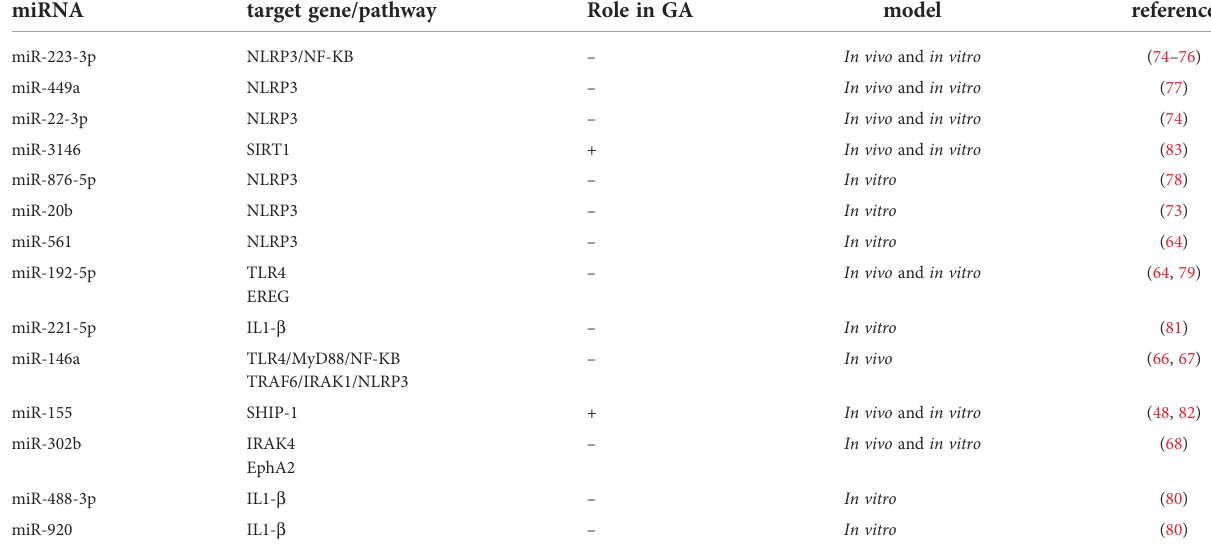
TABLE 2 The miRNAs involved in in fl ammatory immunity.